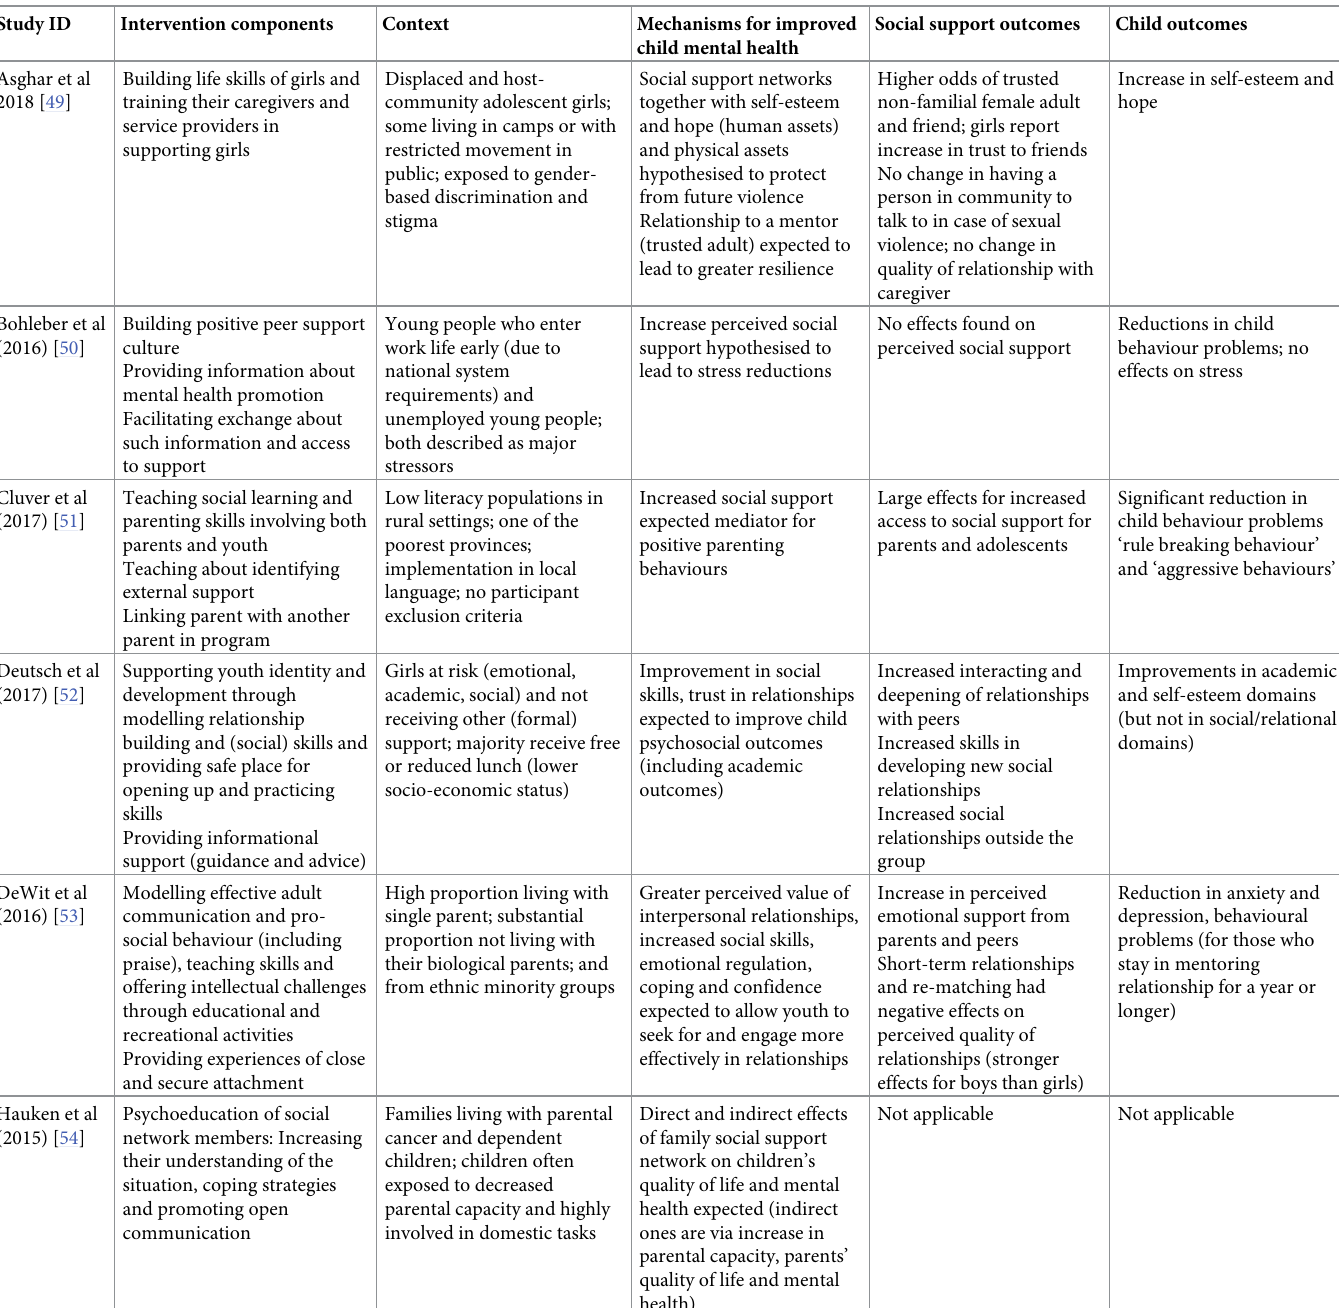
Table 3. Information about programme theories and findings of studies concerned with adolescents (10–18